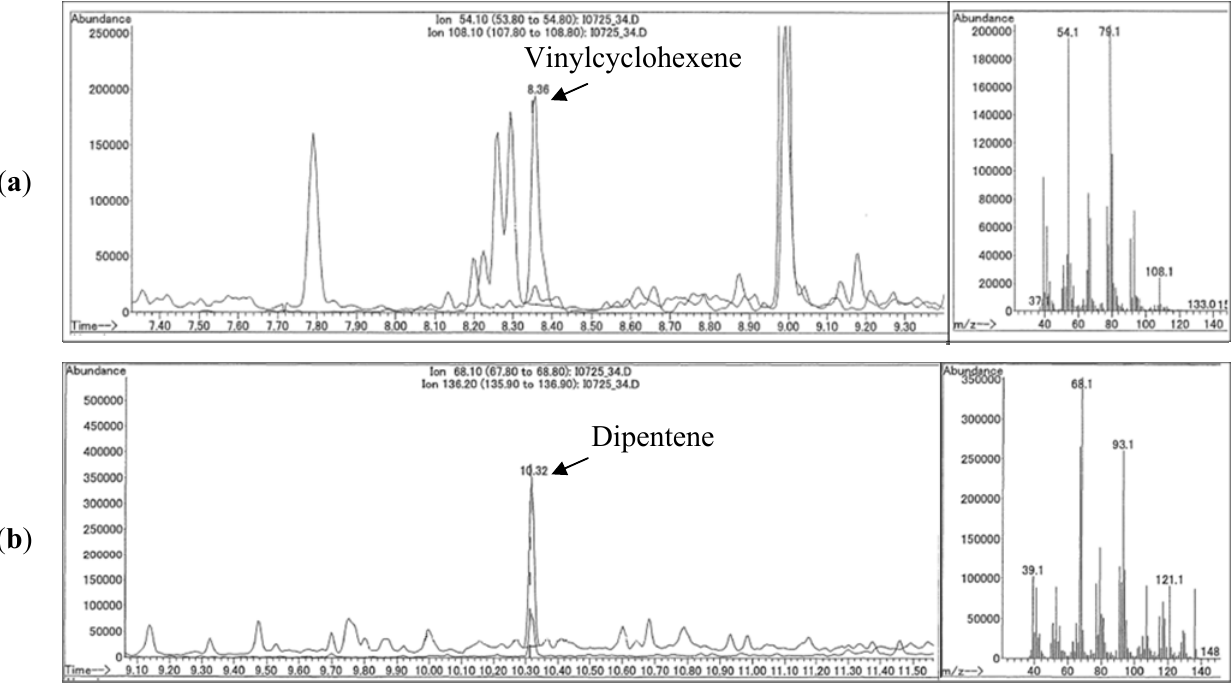
Figure 4. Pyr-GC/MS analysis of a soil sample (longitude, latitude = 34.880222, 135.82389). ( a ) Pyrogram of vinylcyclohexene marker for SBR + BR. ( b ) Pyrogram of dipentene marker for